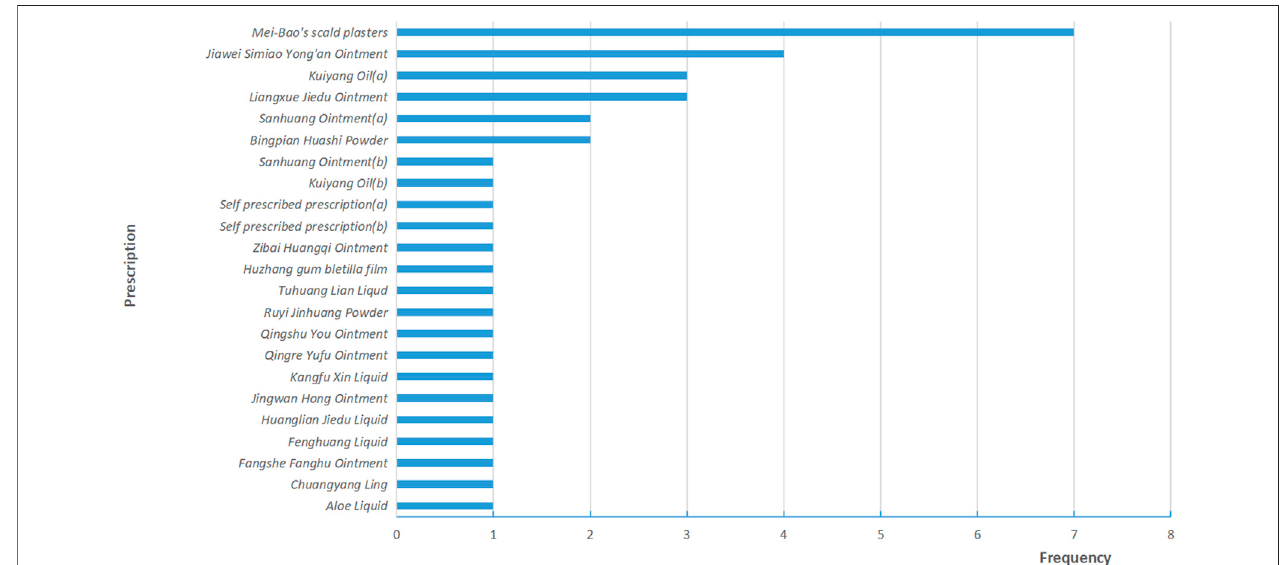
FIGURE 2 | Frequency distribution of prescription.